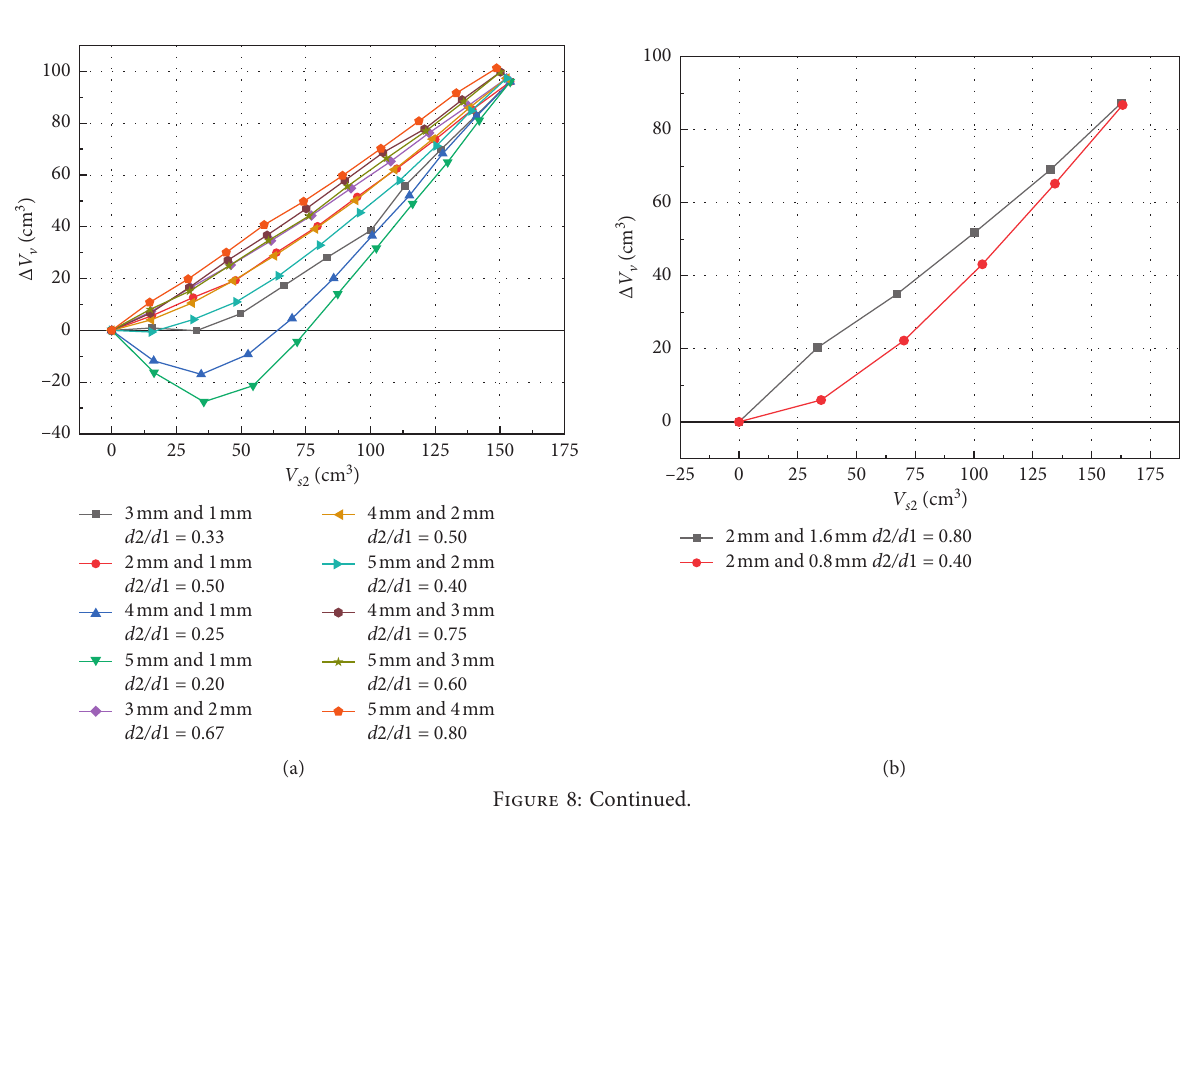
Figure 7: Measured minimum void ratios versus fines content: (a) B ; (b) C ; (c) DS; (d) NS; (e)